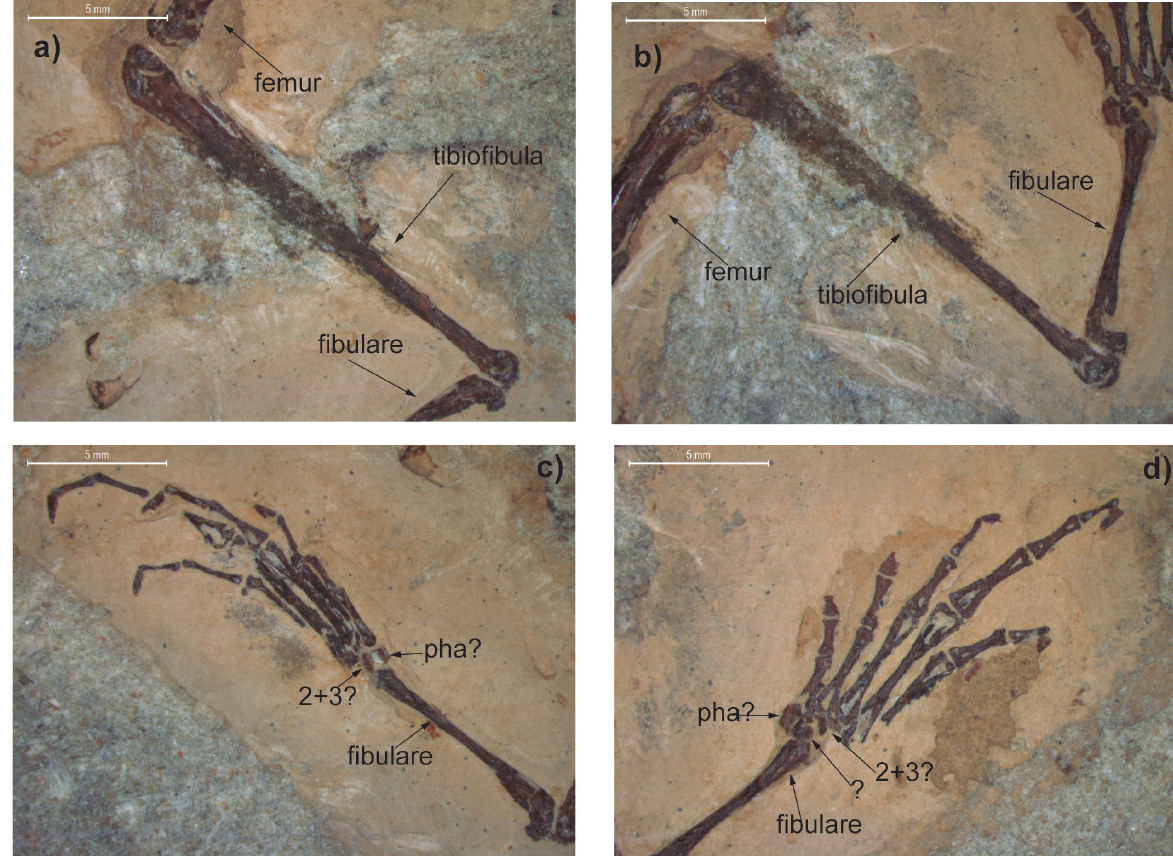
Figure 5. Primaevorana cratensis, holotype (GP/2E-9497) from Crato Formation, Lower Cretaceous (Aptian), region of Nova Olinda, Araripe Basin, Ceará state, Northeastern Brazil. a) Right hindlimb; b) Left Hindlimb; c) Right pes; d) Left pes. Photographs by Ivan Nunes. Abbreviations: 2+3: distal tarsals 2+3; pha: